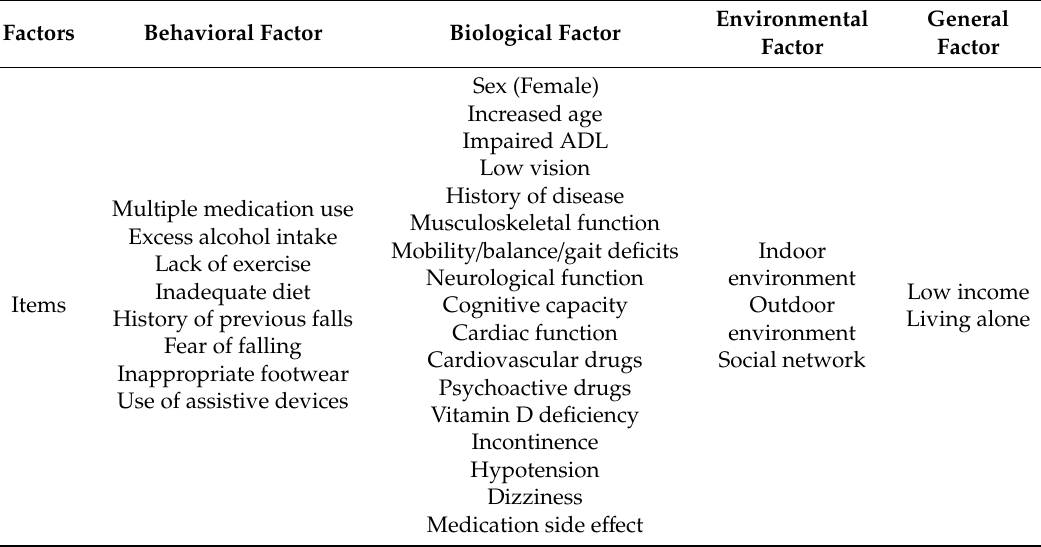
Table 3. Summary of factors and items suggested by the systematic